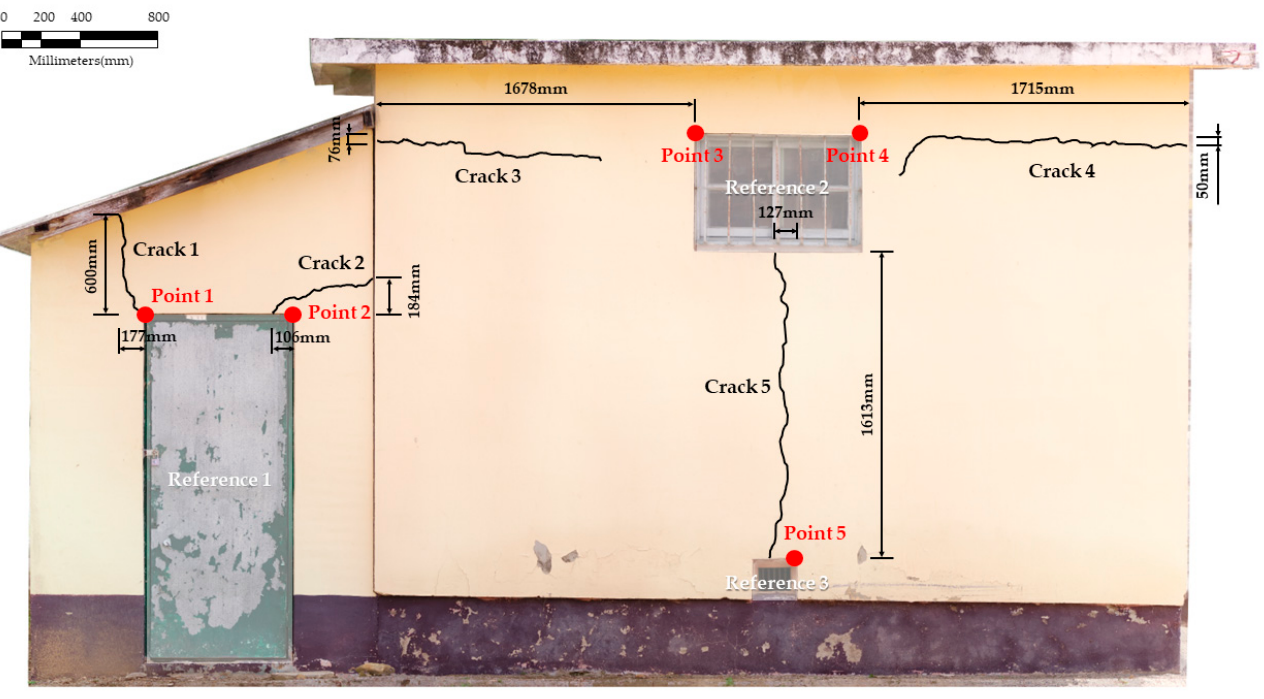
Figure 8. Visualization measured ground truth distance to cracks and reference object. (Location from reference point to remote points of cracks). Table 5. Comparison of estimated relative positions and measured relative positions